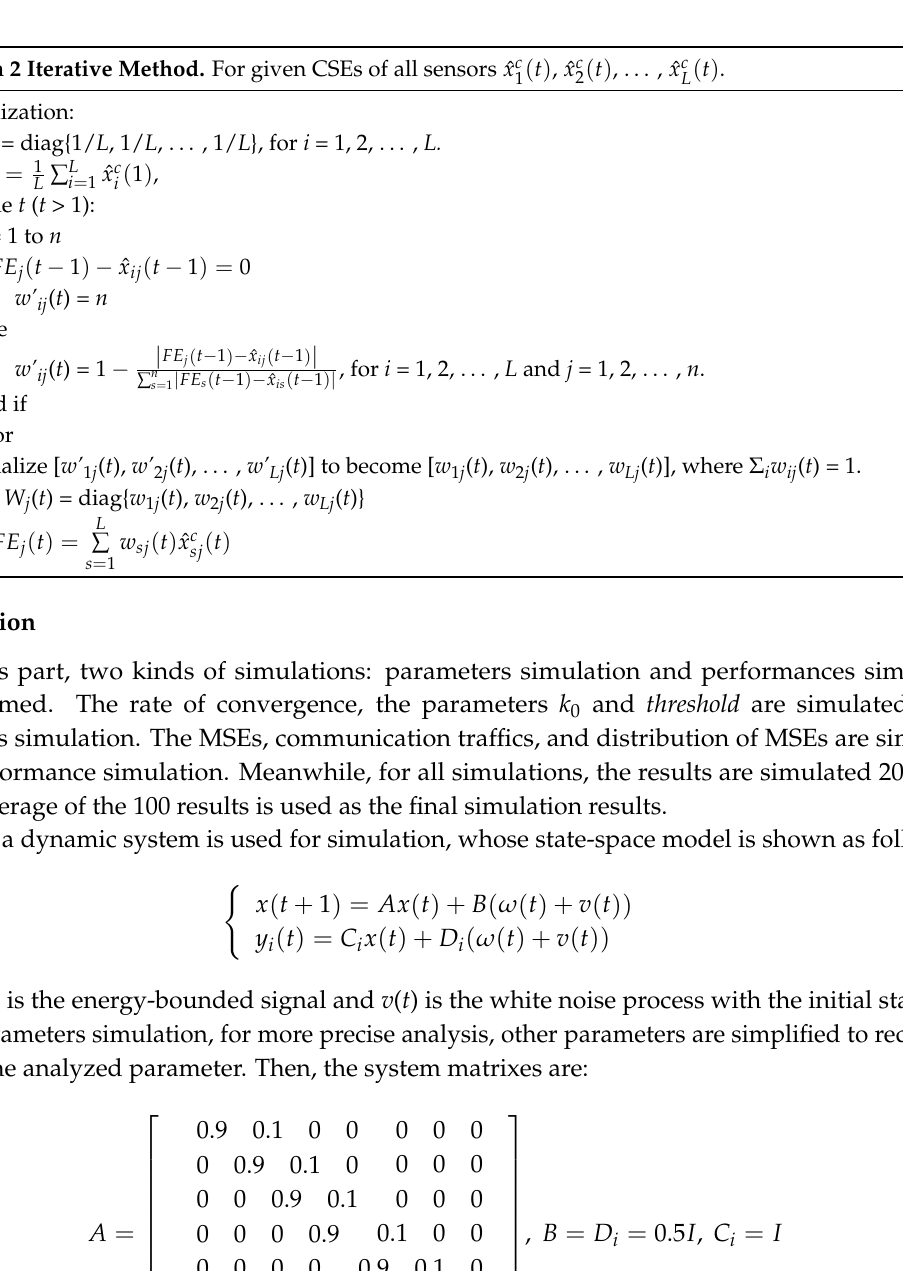
Algorithm 2 Iterative Method. For given CSEs of all sensors ˆ x c